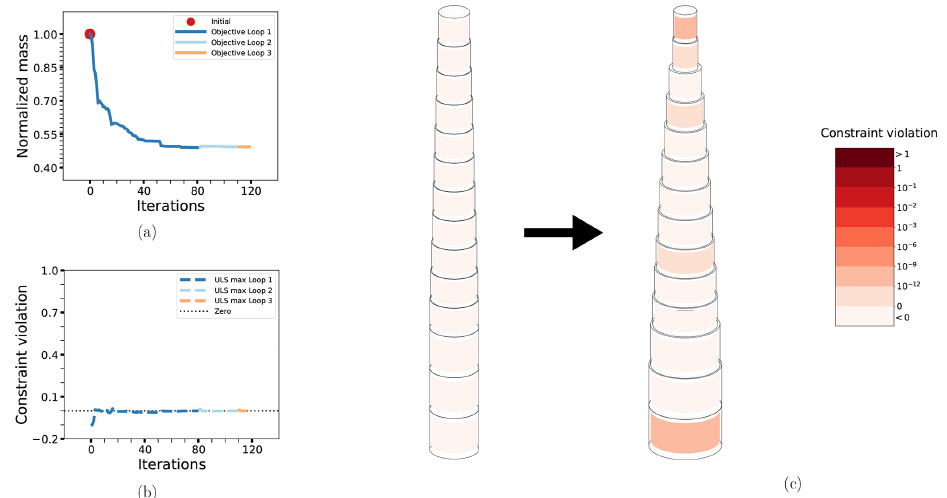
Figure 16. The optimization process for case OC3-PU: the objective function (a) , maximum non-linear constraint violations (b) and the change in the design from initial to final configuration (c) . Details as in previous figures.